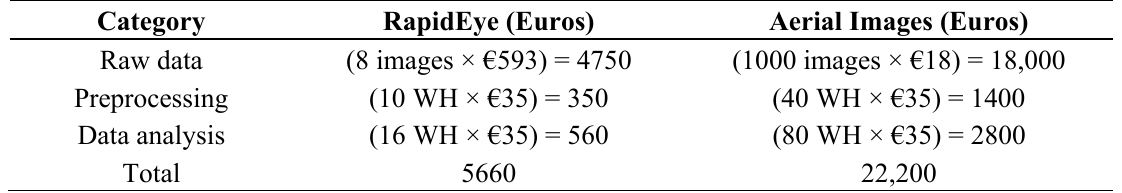
Table 6. Cost comparison of change analysis using RapidEye data and aerial